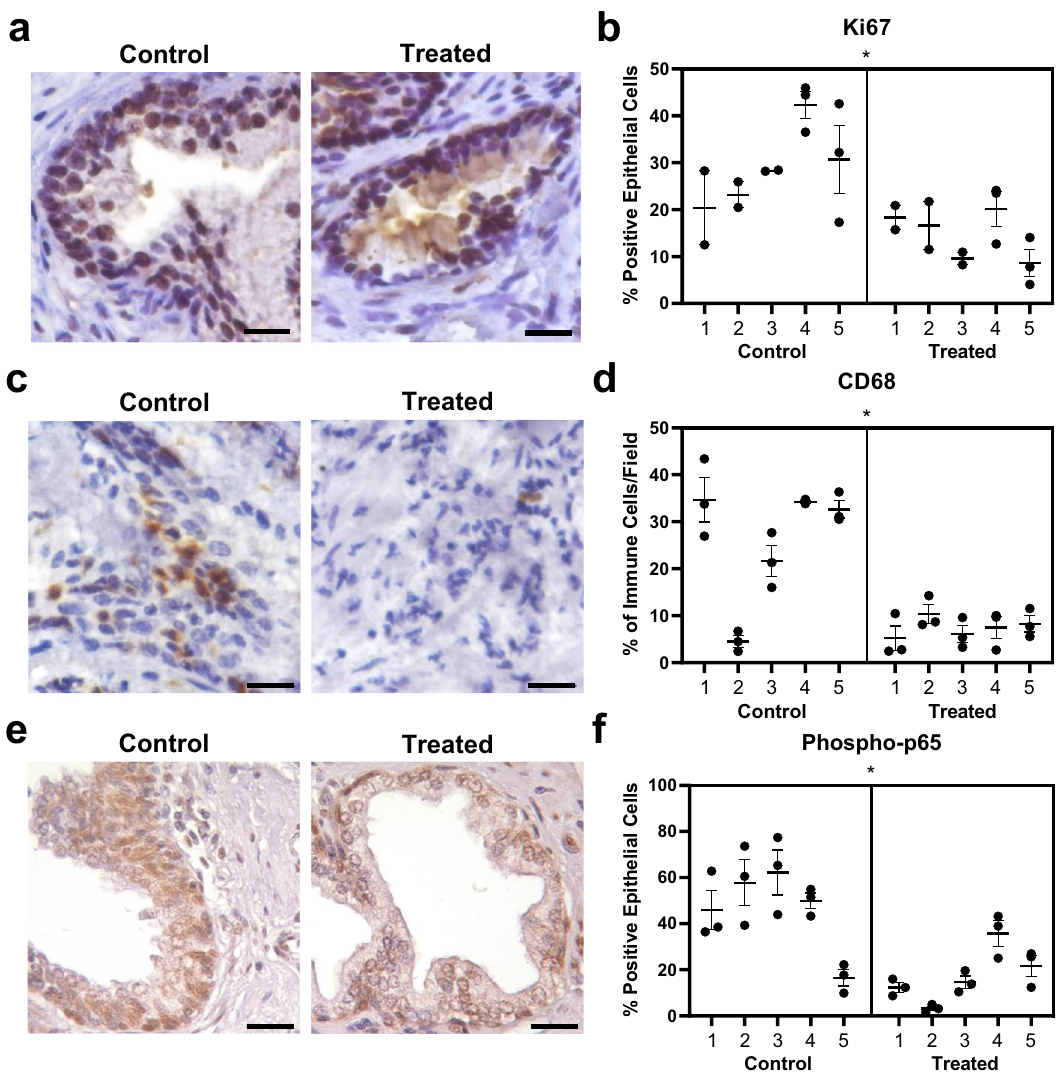
Fig. 7 Patients treated with TNF-antagonists have decreased prostatic epithelial proliferation, macrophage in fi ltration, and NF κ B activation. Human transition zone tissues from patients taking TNF-antagonists at the time of radical prostatectomy or matched controls ( n = 5 per group) were used for histological evaluation. a Representative images of IHC staining for Ki67 in control or treated patients, where brown color in the nucleus indicates positive staining. b Quantitation of IHC staining for epithelial Ki67 in control or treated patients, indicated as the percent Ki67 + epithelial cells per fi eld (* p = 0.0123). c Representative images of IHC staining for CD68 in control or treated patients, where brown color indicates positive staining. d IHC quantitation indicating the abundance of CD68 + macrophages, represented as the portion of all immune cells per fi eld (* p = 0.0148). e Representative images of phospho-p65 staining via IHC in control or treated patients, where brown color in the nucleus indicates positive staining. f Data represents the quantitation of IHC staining for epithelial phospho-p65 staining in control or treated patients, represented as the percent positive epithelial cells per fi eld (* p = 0.0172). b , d , f Data indicate the mean ± SEM of the percent positive cells per fi eld, where individual points indicate separate fi elds for each patient. Comparison of control and TNF-antagonist treated groups were conducted using a two-tailed nested t test and asterisks indicate the signi fi cance of the treatment. Source data are provided as a Source Data fi le. Scale bars = 20 µ